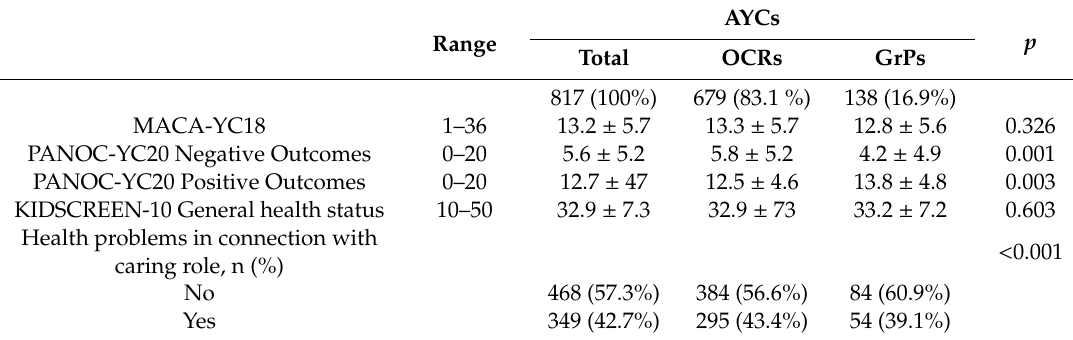
Table 2. Outcome variables per care recipients: AYC of OCRs and AYCs of GrPs.